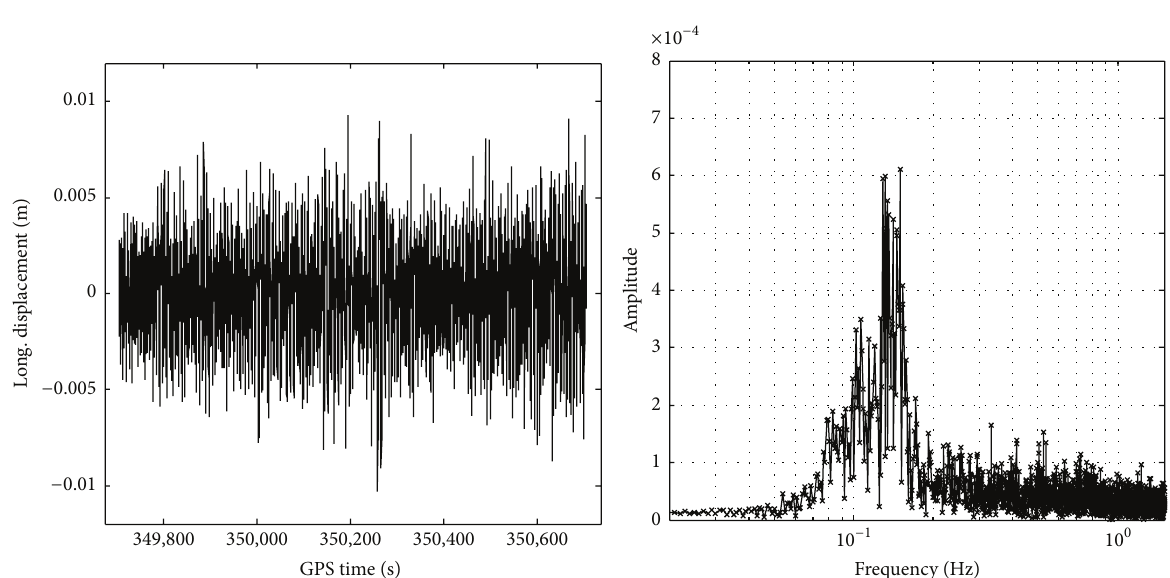
Figure 24: The filtered longitudinal displacements and corresponding frequencies.